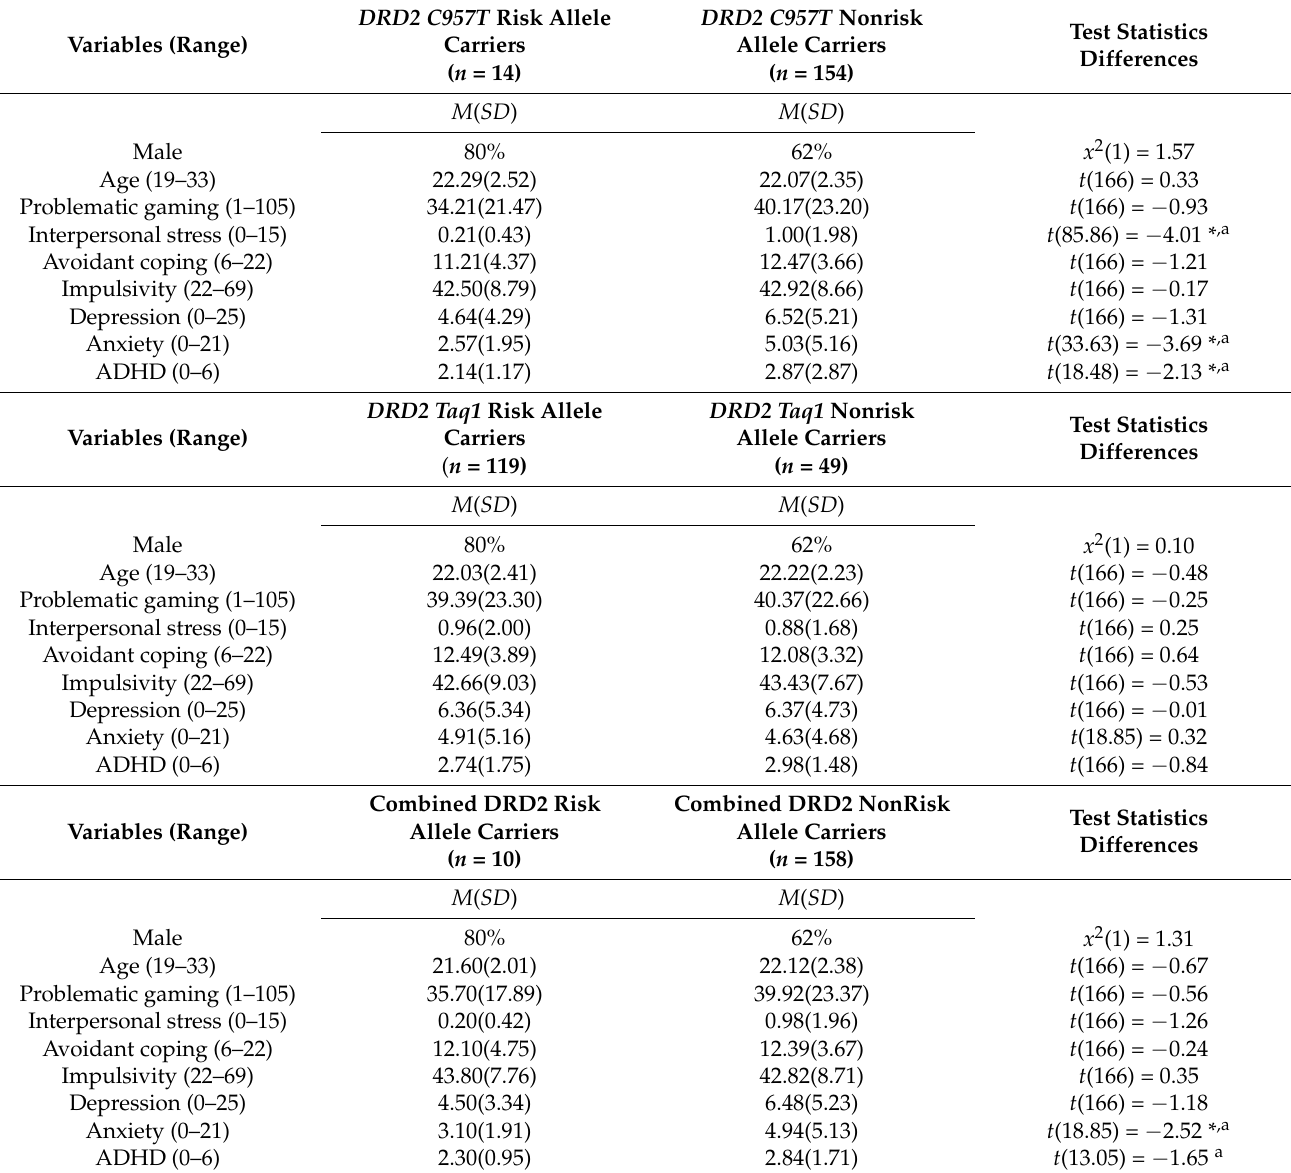
Table 2. Mean and percentages of study variables as DRD2 allele